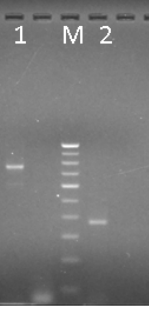
Figure 3. Validation of BjuWRR1 -VD marker: 1-Varuna (761 bp), 2-Bio-YSR (366 bp), M-100 bp ladder.